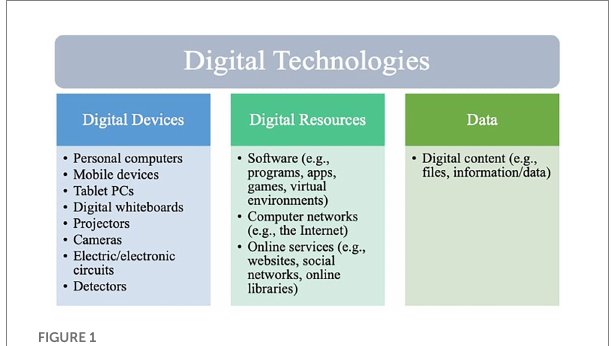
FIGURE 1 Concept of digital